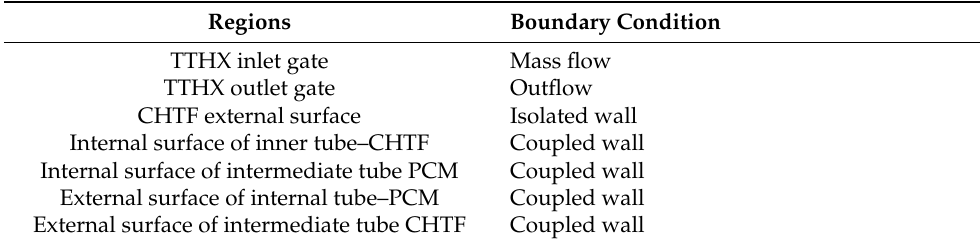
Table 1. Boundary conditions.